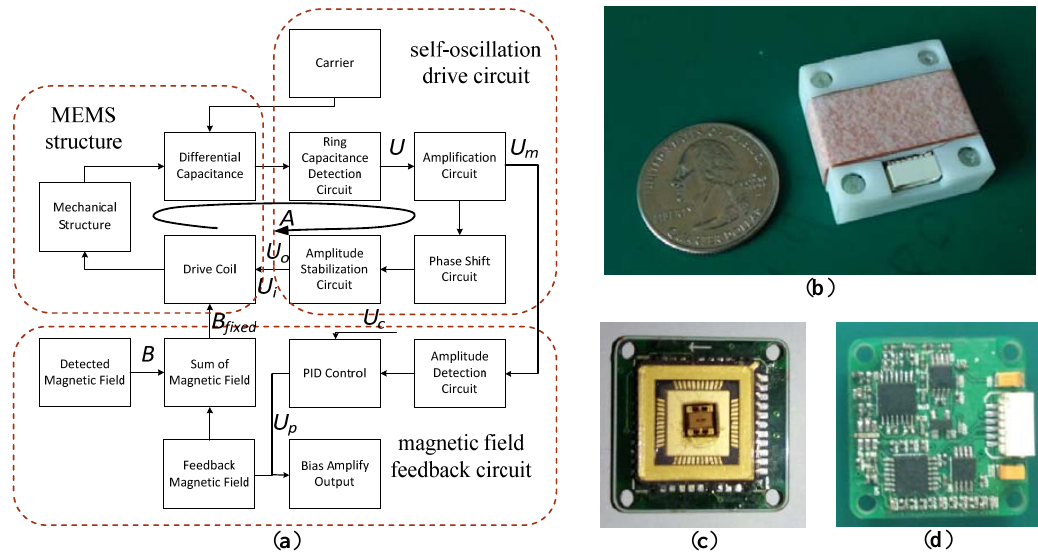
Figure 3. ( a ) Block model of the closed-loop control; ( b ) the prototype; ( c ) packaged MEMS structure; ( d ) circuit of the closed-loop control.